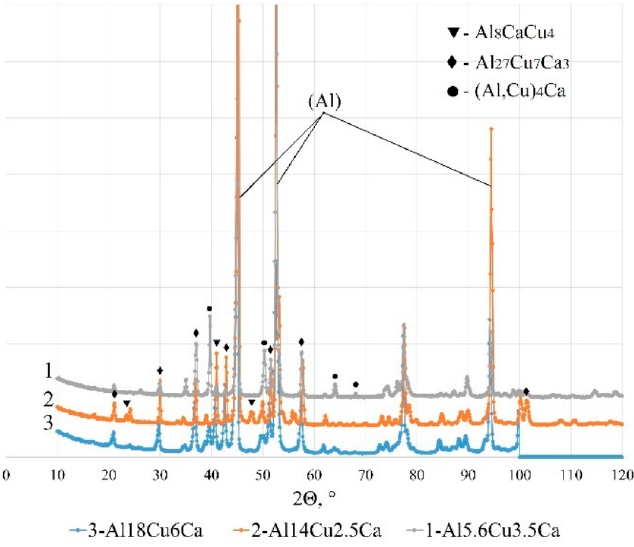
Figure 4. XRD data for (1) Al5.6Cu3.5Ca, (2) Al14Cu2.5Ca and (3) Al18Cu6Ca alloys. CoK α radia- tion.